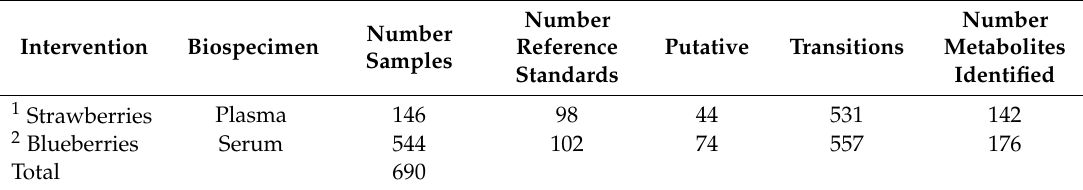
Table 2. Methodology history of